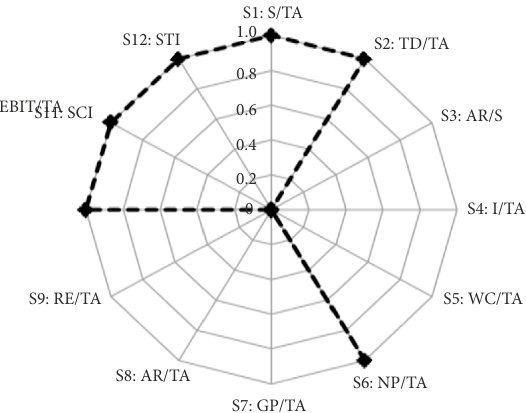
Figure 3. The selected features by